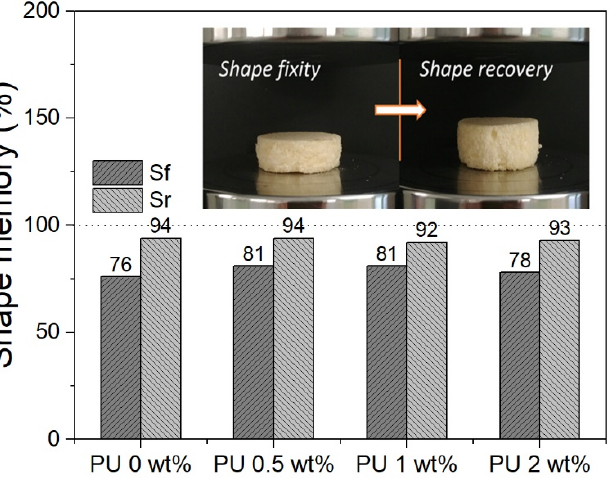
Figure 10. Shape memory performances of PU cylindrical foams with and without microcapsules.